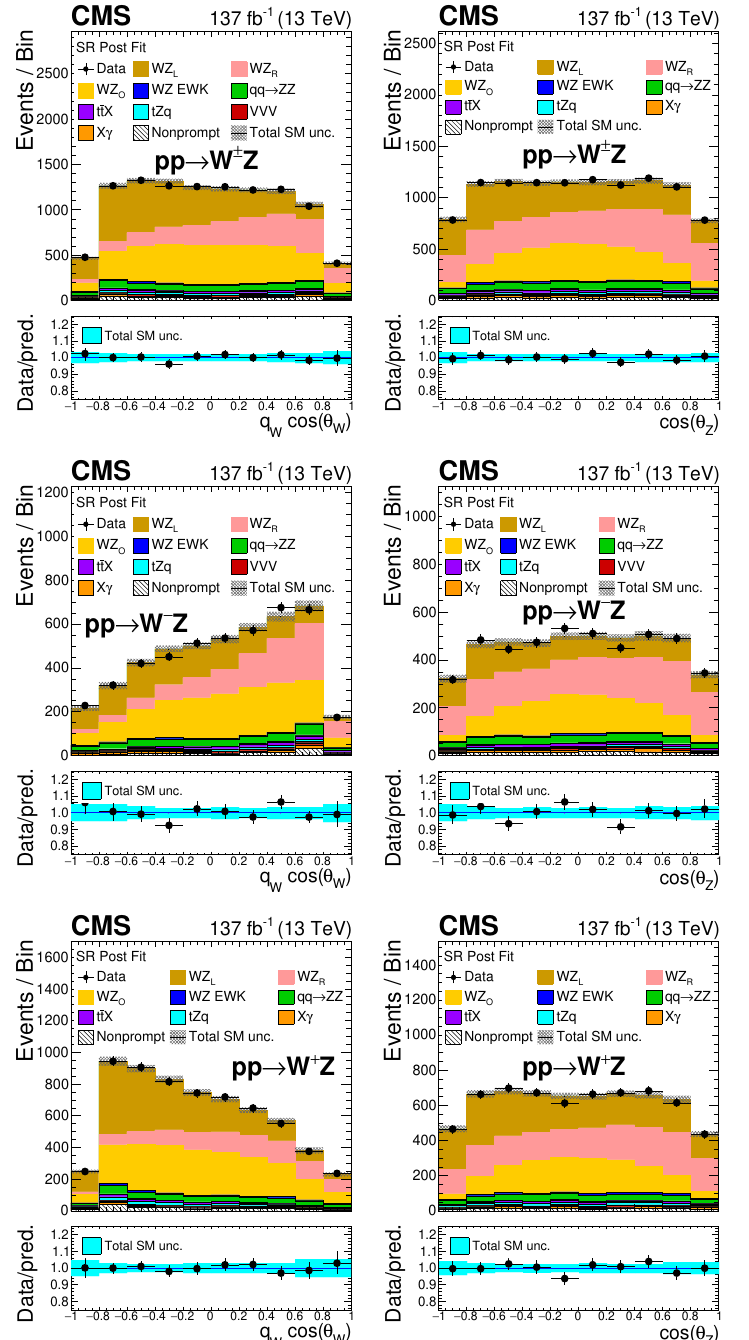
Figure 10 . Distribution of the cosine of the polarization angle for different final-state charges and boson flavours after each of the corresponding fits for the extraction of the polarization frac- tions. From left to right: W and Z bosons. From top to bottom: charge-inclusive (total), negative final-state charge, and positive final-state charge. The differently polarized final states of the cor- responding boson are shown in each of the cases. X g includes Z g , W g , tt g and WZ g production. The label ttX includes ttZ , ttW , and ttH production. The shaded band in the ratio shows the sum of uncertainties in the signal and background